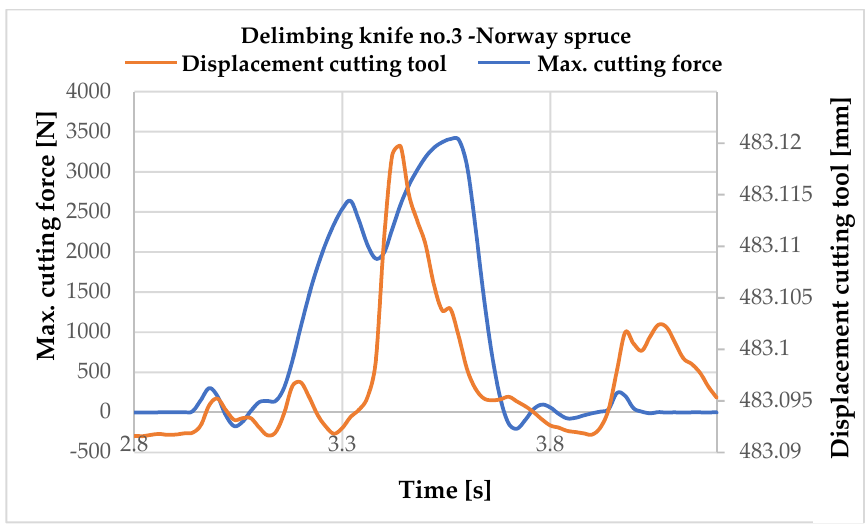
Figure 11. The course of the experimental measurement of delimbing—delimbing knife No.3.